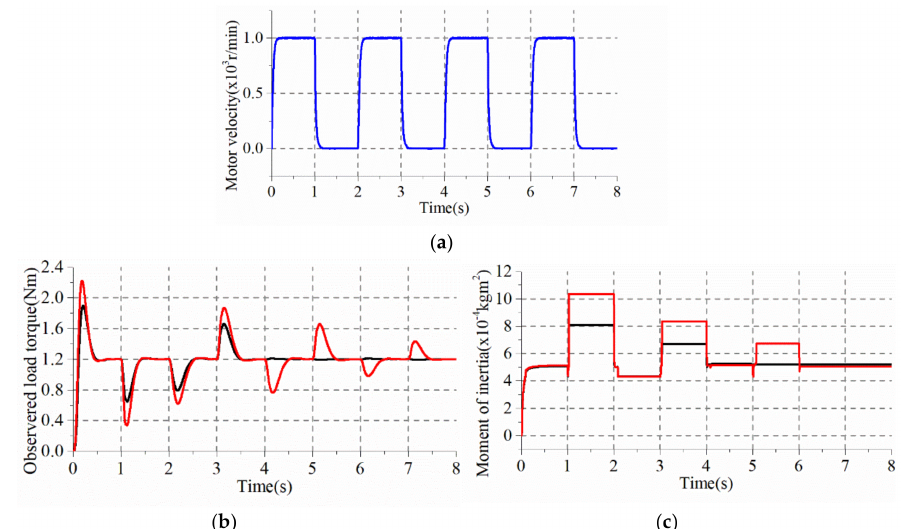
Figure 4. Simulation Comparison of the two algorithms with initial value ˆ J ( 0 ) = 5 J under 1.2 Nm load torque and repeated speed command. ( a ) Speed response (blue); ( b ) Observed load torque ˆ T L (black line denotes AKO-RLS result, red line denotes KO-RLS result); ( c ) identified inertia ˆ J (black line denotes AKO-RLS result, red line denotes KO-RLS result).